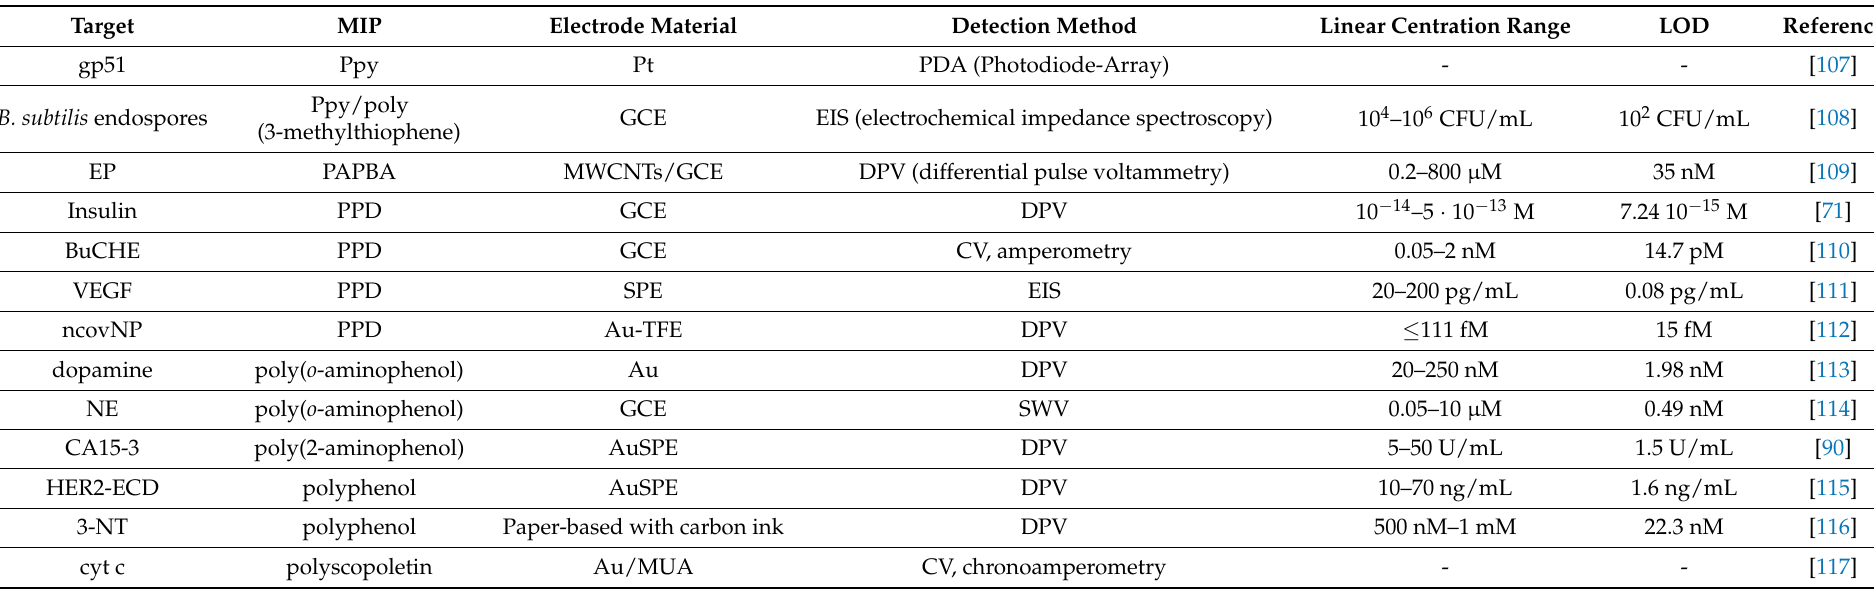
Table 2. Summary of some eMIP-based sensors for clinically relevant biomarker, featuring polymer matrix, electrochemical detection method, linear concentration range and detection